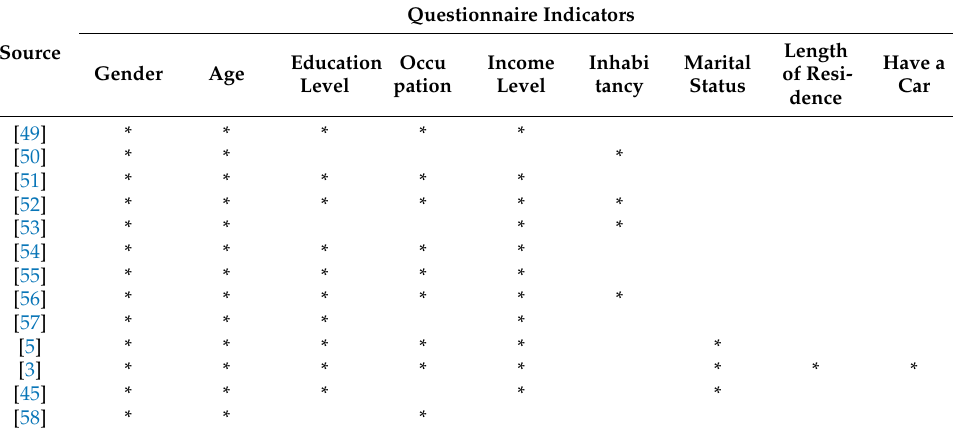
Table 2. Using behavioral reference